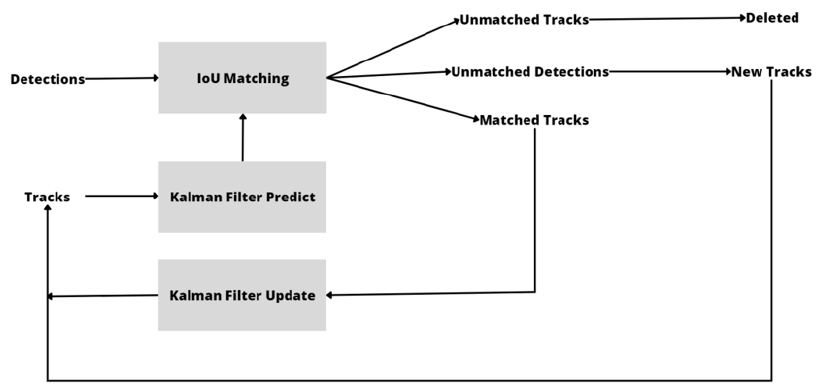
Figure 2. Overview of the object tracking SORT algorithm.